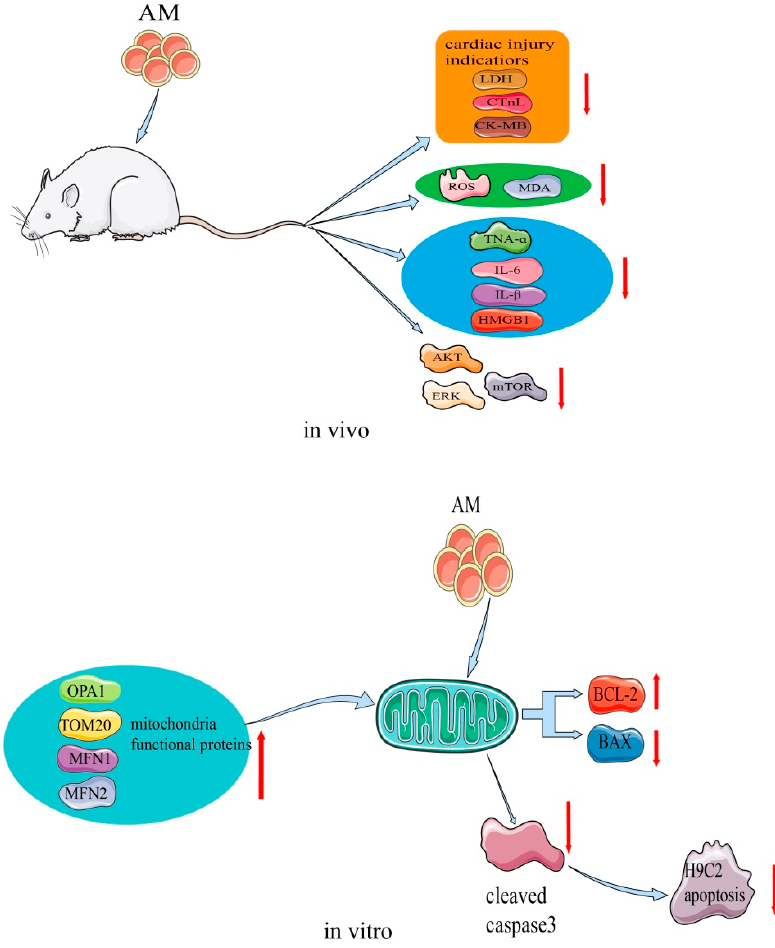
Figure 7. Mechanism of AM for its myocardial protective effects.